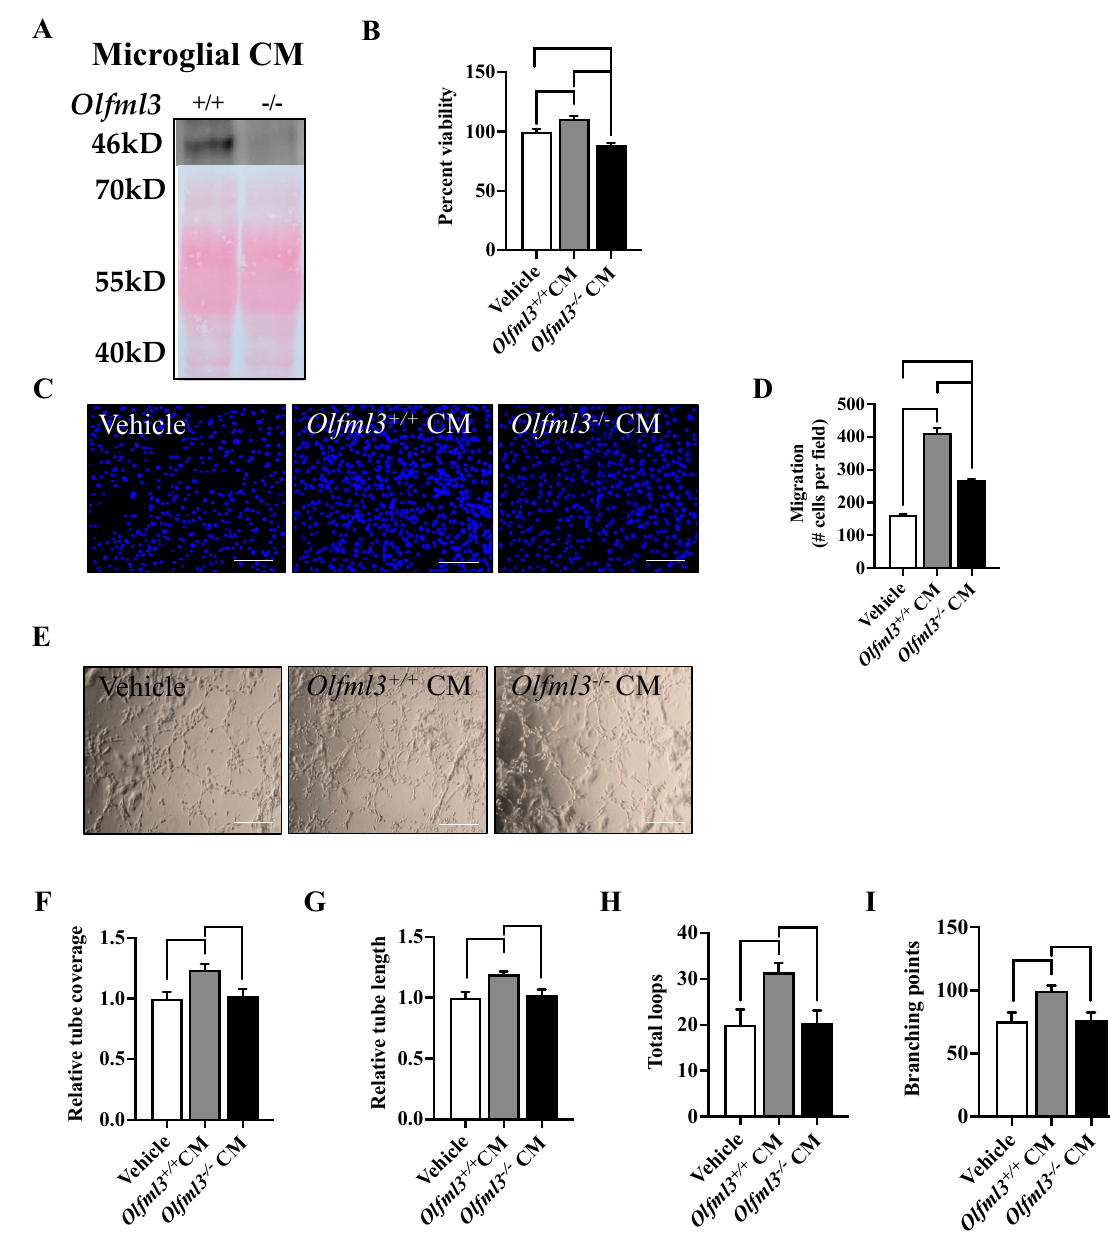
Figure 3. Microglia-derived OLFML3 is necessary for microglia-induced angiogenesis. ( A ) Representative immunoblot for OLFML3 on conditioned medium (CM) revealed positivity immunoreactivity at the predicted molecular weight (46 kD) in isogenic control medium, but not CM from Olfml3 − / − microglia. The corresponding membrane Ponceau stain is pictured as a loading control. ( B ) Exposure to isogenic control CM increased EC viability. Notably, EC viability was reduced following exposure to Olfml3 − / − microglial CM relative to vehicle-treated and isogenic control CM. ( C ) Representative images of primary mouse brain EC migration across experimental conditions. ( D ) Exposure to isogenic control and Olfml3 − / − microglial CM increased EC migration. However, EC migration was mitigated following exposure to Olfml3 − / − microglial CM relative to isogenic control CM. ( E ) Representative images of primary mouse brain EC differentiation across experimental conditions; scale bars 50 μ m. EC differentiation was increased following exposure to isogenic control CM, but not Olfml3 − / − microglial CM, as determined by ( F ) relative tube coverage, ( G ) relative tube length, ( H ) total loops, and ( I ) branching points. Comparisons based on one-way ANOVA with Tukey’s multiple comparisons test; bars represent group mean with standard error of the mean (SEM). Relative tube coverage (Figure 3E,F), relative tube length (Figure 3E,G), total loops (Figure 3E,H), and branching points (Figure 3E,I) were all increased in Olfml3 +/+ CM- treated ECs relative vehicle- and Olfml3 − / − CM-treated ECs, respectively ( p < 0.05). These